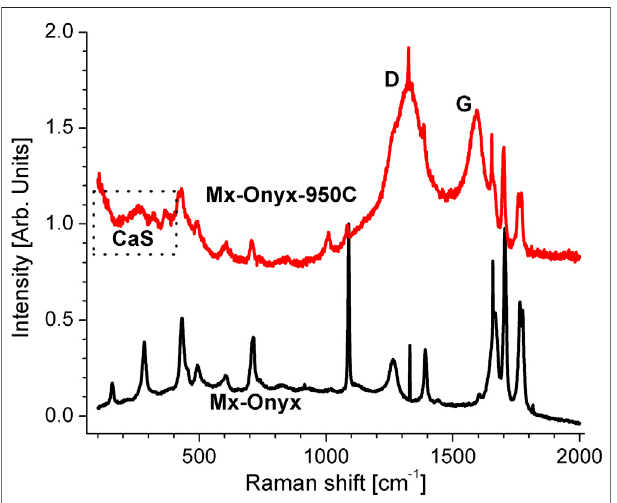
FIGURE 4 | Raman spectra of Mx-Onyx and Mx-Onyx-950C.